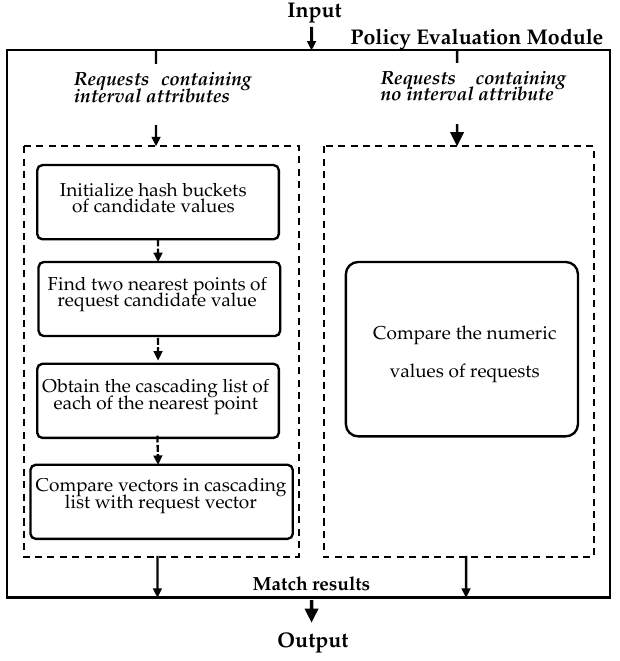
Figure 4. Structure and workflow of fast policy evaluation module of Poliseek.